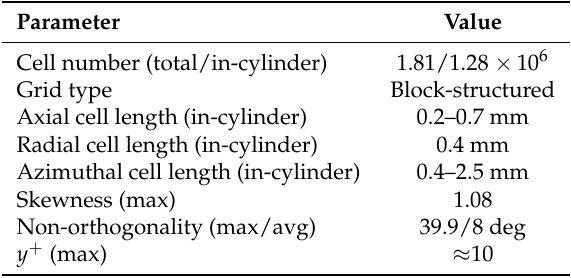
Table 5. Main parameters of the computational grid for the piston/cylinder